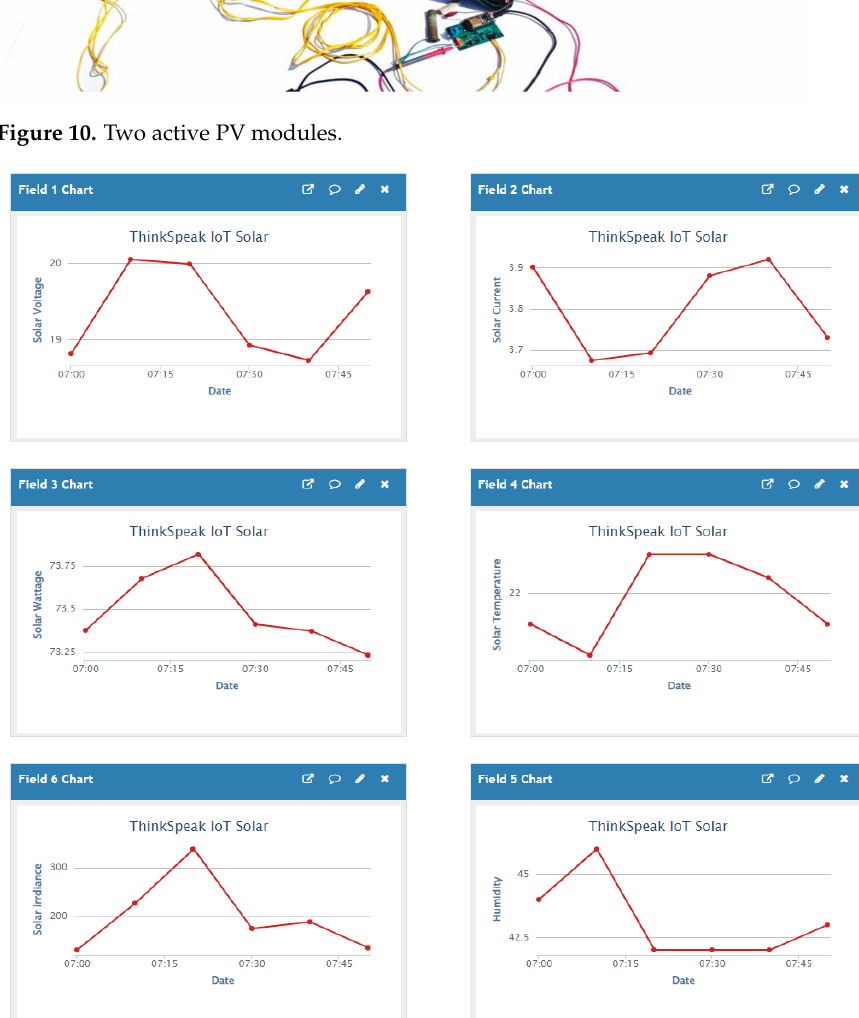
Figure 11. Real-time results for two active PV modules.